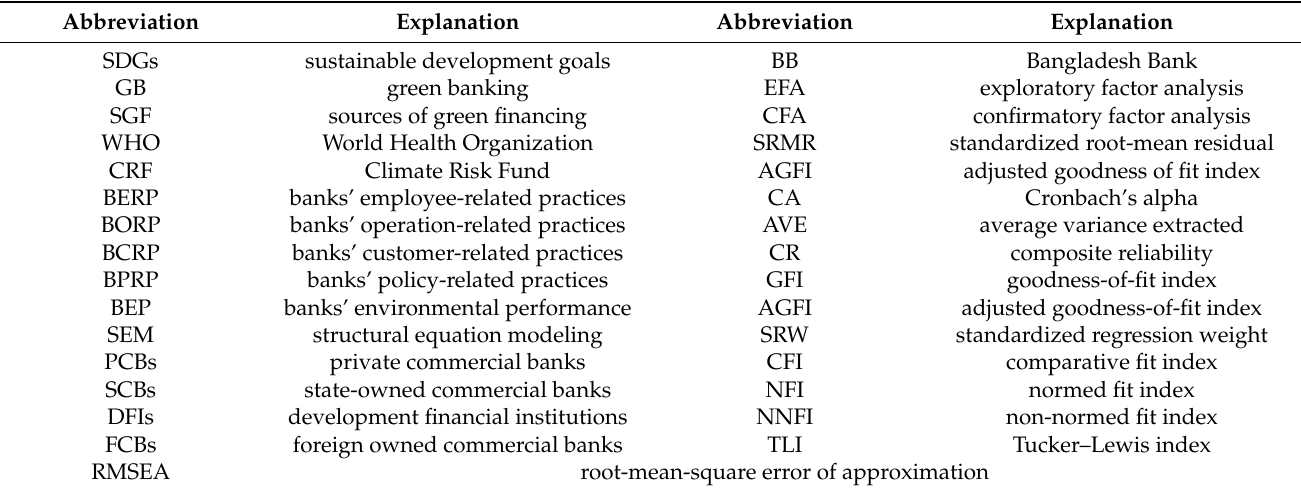
Table 1. List of abbreviations and terminologies used in the